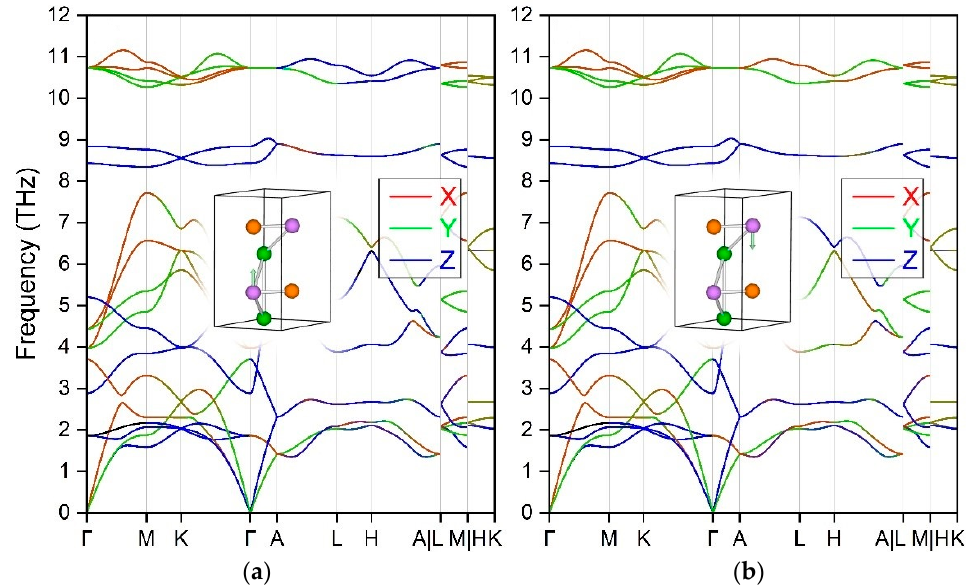
Figure A4. The phono band spectra with vibration mode decomposition for two Li atoms in the primitive cell: Li (1/3, 2/3, 1/4) for ( a ) and Li (1/3, 2/3, 3/4) for ( b ). The two insets indicate the vibration direction of the corresponding Li atom in the primitive cell, as indicated by the color arrows.